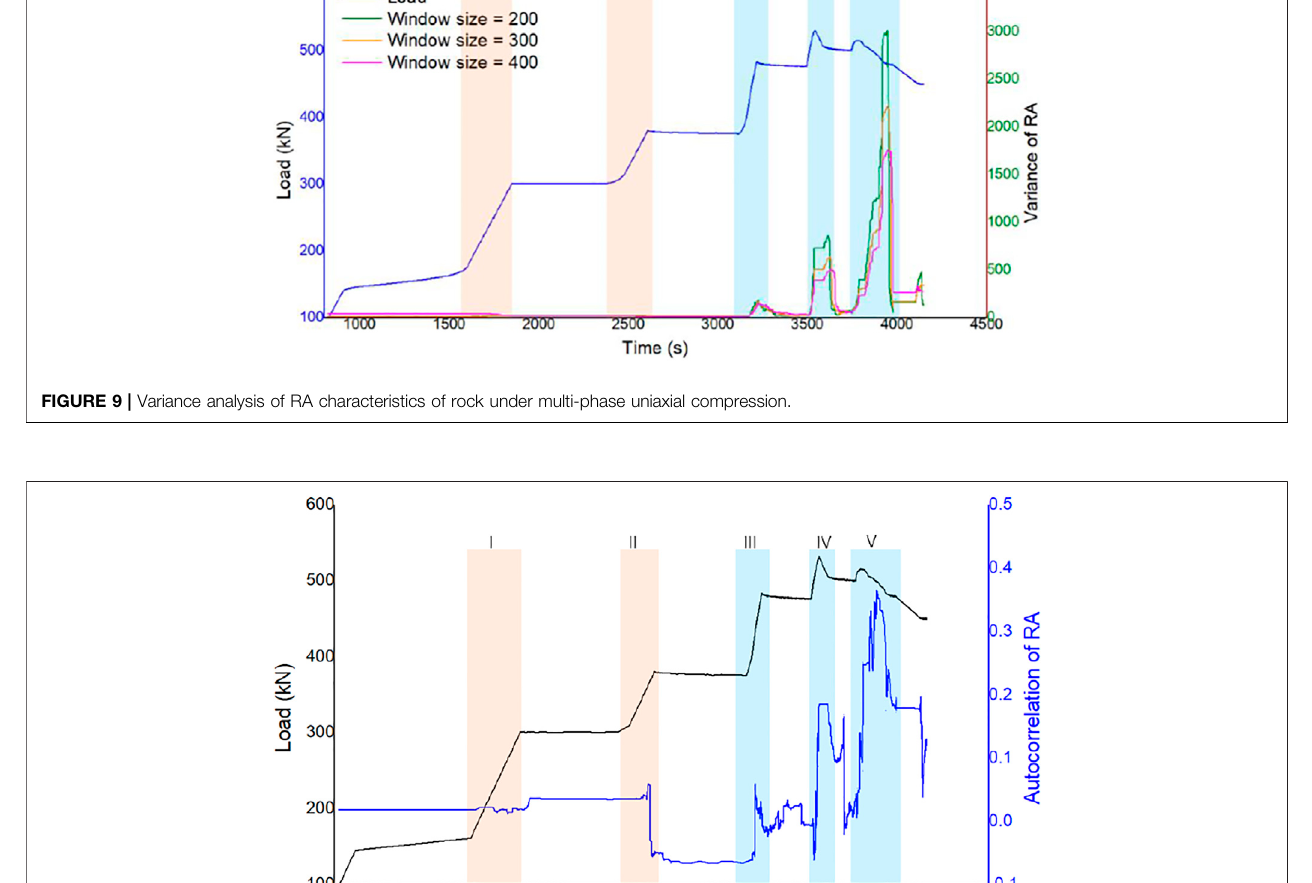
Frontiers in Earth Science |